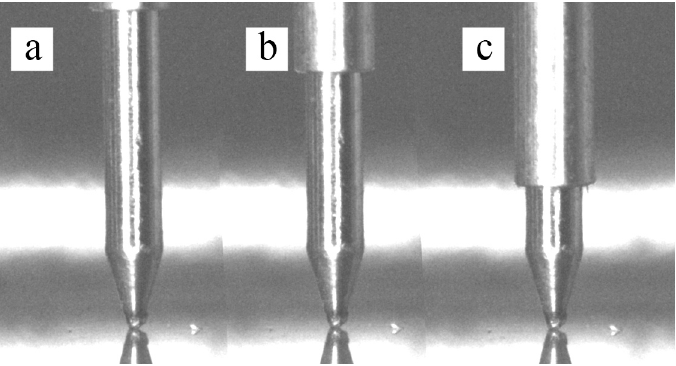
Figure 10. Rigid electrode positions exerting different clamping pressure on the surface Pa< Pb < Pc.